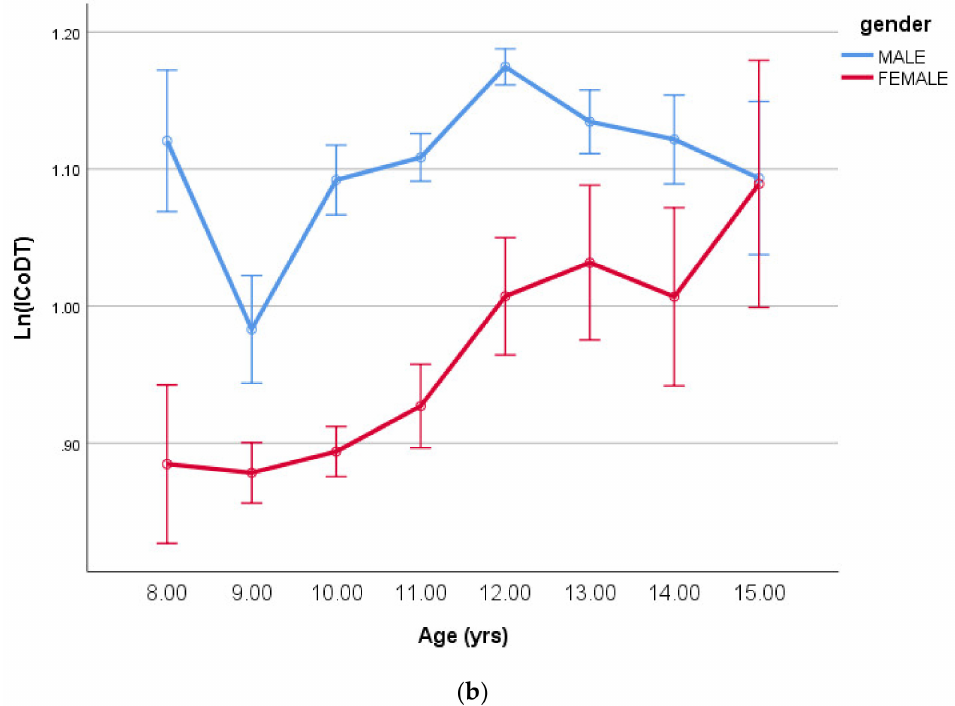
Figure 5. ( a ) Log-transformed handgrip strength (means ± SE) by age having controlled for body size/shape and maturity offset (covariates in Table 5). ( b ) Log-transformed Illinois Change of direction test (means ± SE) by age having controlled for body size/shape and maturity offset (covariates in Table 5 DV